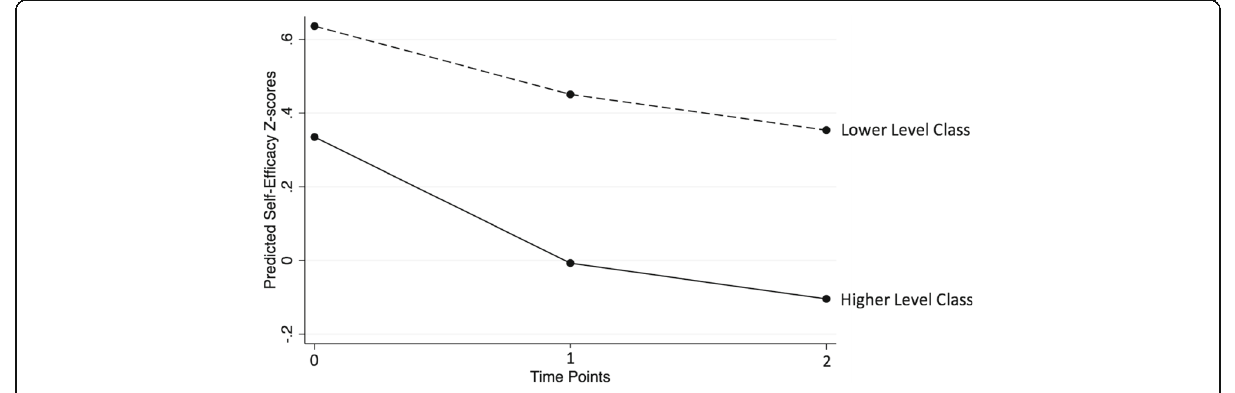
Fig. 2 Predicted self-efficacy trajectories, by class